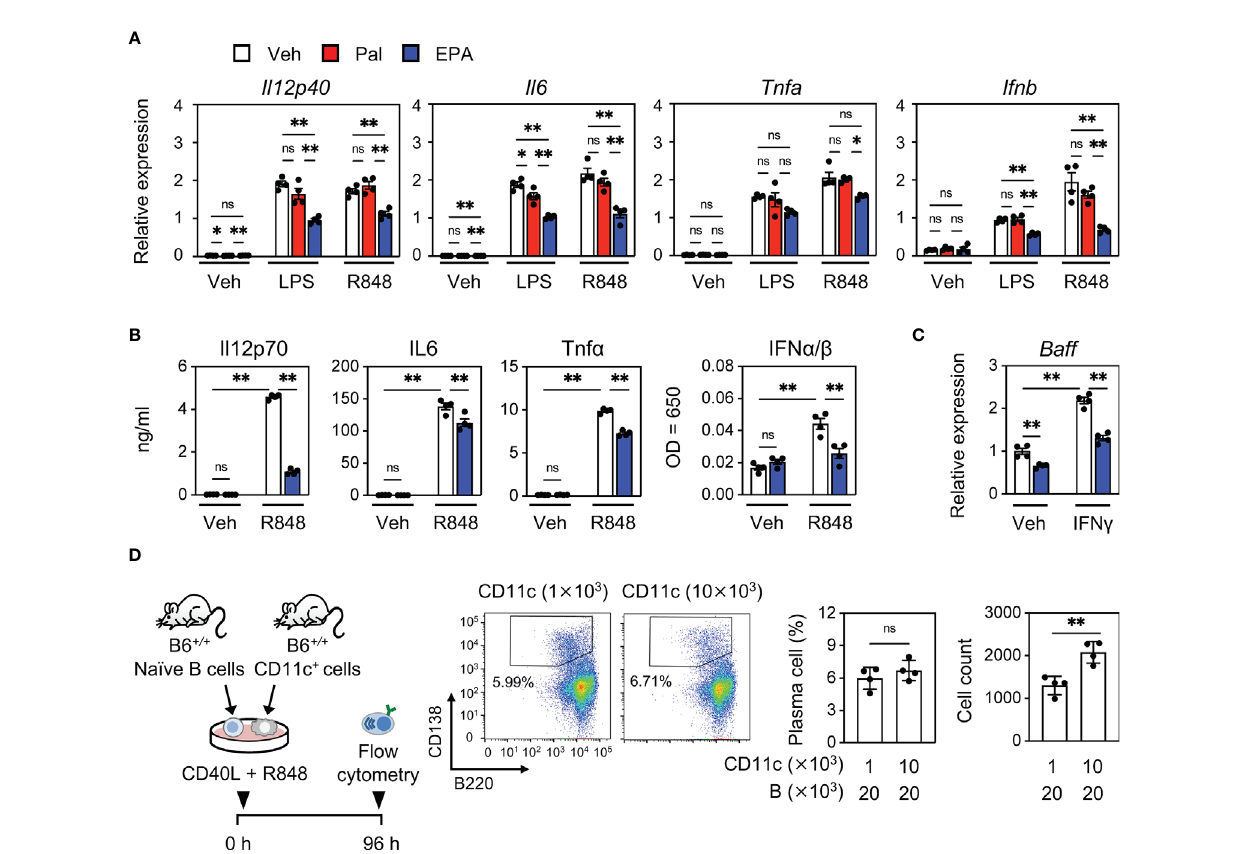
FIGURE 5 | EPA suppresses in fl ammatory cytokine production in CD11c + dendritic cells. (A, B) Gene expression (A) and cytokine levels in culture medium (B) . Bone marrow cells from B6 +/+ mice were differentiated to dendritic cells. Bone marrow – derived dendritic cells (BMDCs) were treated with ethanol (Veh), Pal (50 µM) or EPA (50 µM) for overnight, followed by stimulation with PBS (Veh), LPS (10 ng/ml) or R848 (1 m g/ml) for 4 h. (C) Gene expression of Baff . BMDCs were treated with ethanol (Veh) or EPA (50 µM) for overnight, followed by stimulation with recombinant murine IFN g (5 ng/ml) for 6 h. (D) Experimental protocol (left), representative fl ow cytometry plots (middle), and percentages and cell counts of CD138 + B220 lo plasma cells in live cells (right) analyzed by fl ow cytometry. Naïve B cells and CD11c + cells isolated from B6 +/+ spleen were co-cultured at indicated cell numbers in the presence of CD40L (1 m g/ml) and R848 (1 m g/ml) for 96 h. n = 4 per group. Data shown are mean value ± SEM of representative experiments at least three times independently. Statistical analysis was performed with Turkey ’ s test (A – C) and unpaired Student ’ s t test (D) . *p < 0.05; **p < 0.01; ns, not signi fi